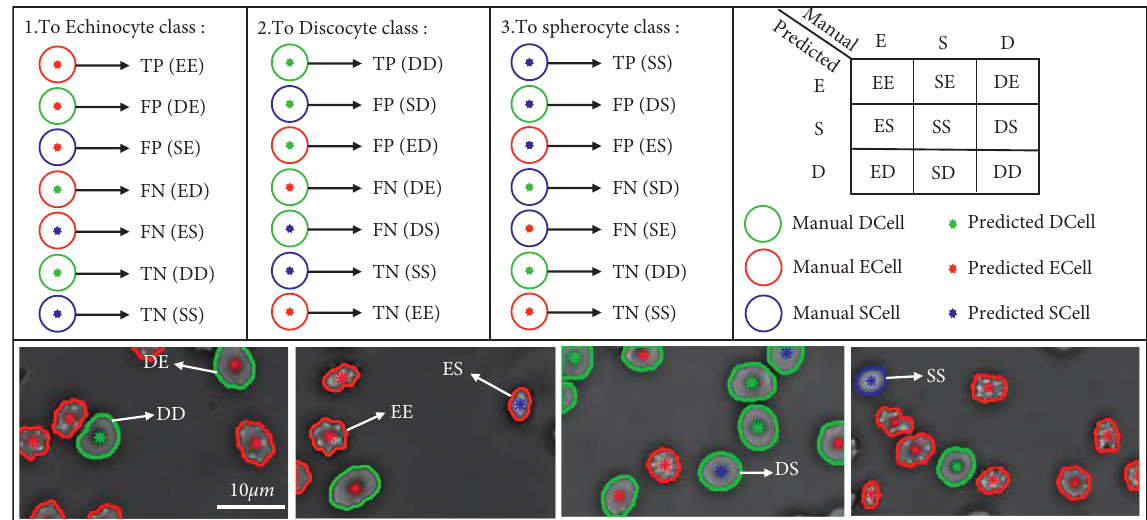
Figure 4: The confusion matrix shown on the top right for one-to-one matching evaluation is used to evaluate the accuracy of RBC classification detection. The figure in the upper left corner shows examples of DD, DE DS, ED, EE, ES, SD, SE, and SS. For point cor- respondence, we do not use specificity or true negative (TN) rate because most image pixels are